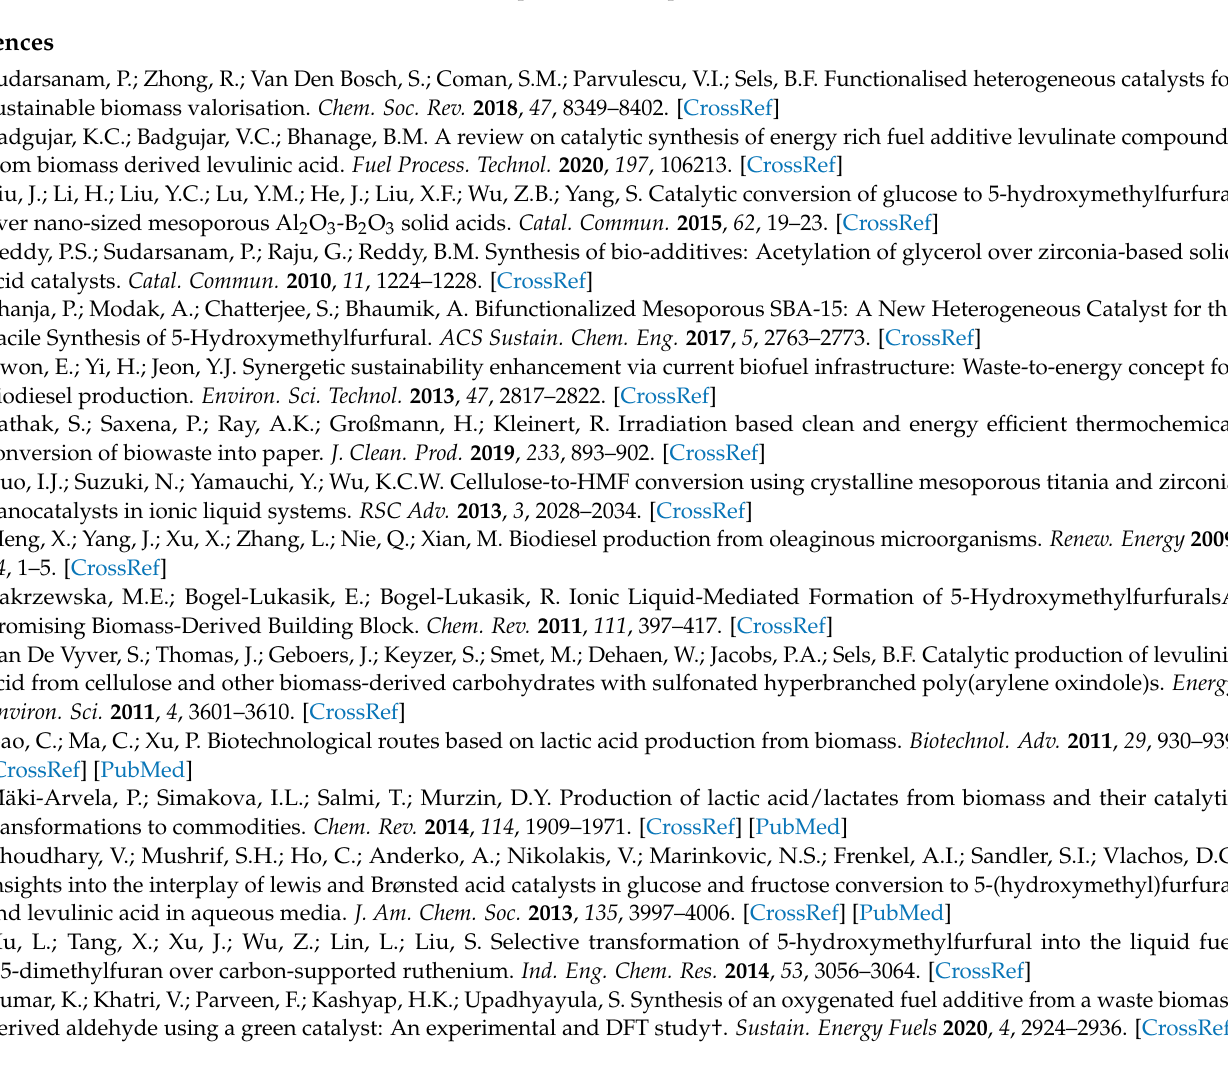
purified LA. Figure S2: 1 H NMR spectrum of purified